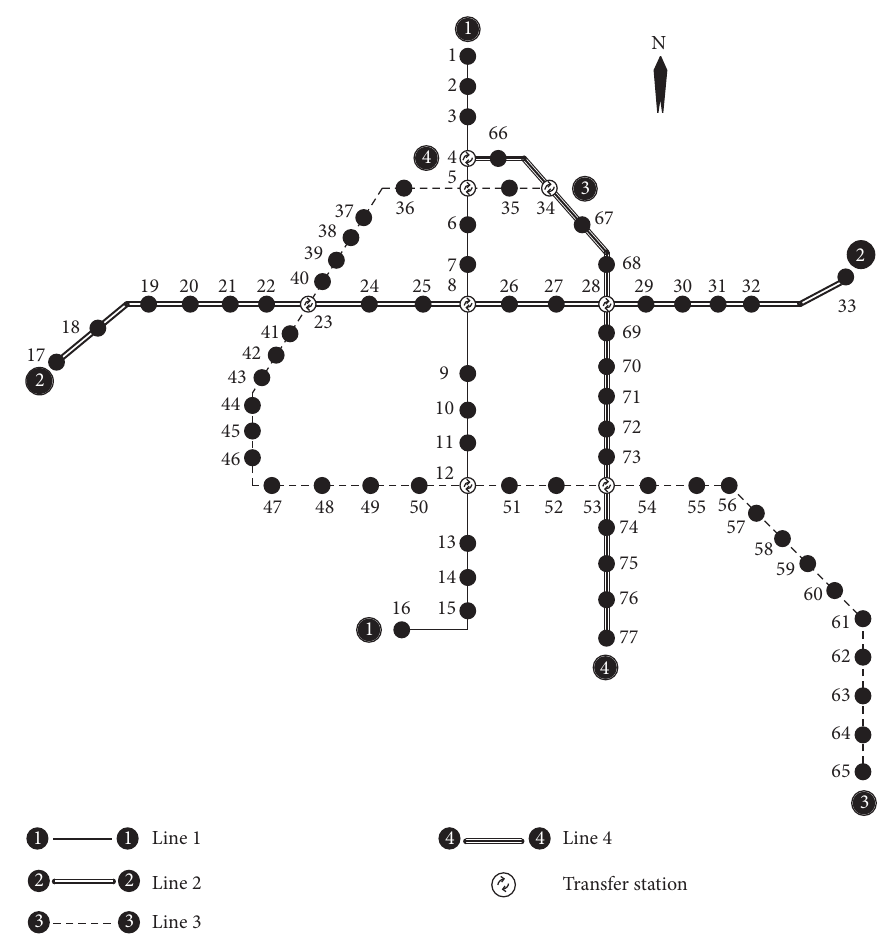
Figure 2: Layout of the urban rail transit Table 1: Maintenance support points and their coverages in basic scenario.